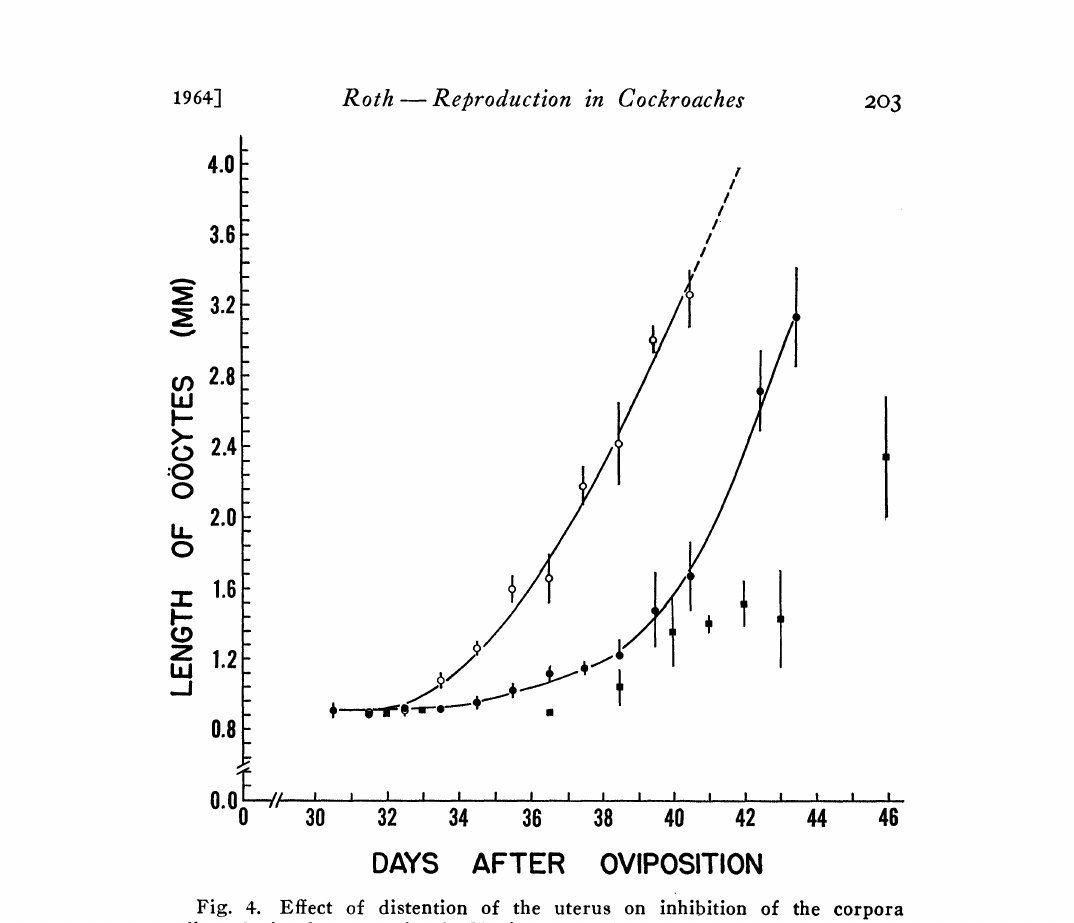
Fig. 4. Effect of distention of the uterus on inhibition of the corpora ,.llta during late gestation in N. cinerea. Solid circles Carrying o/thecae (controls). Ten to 18 females (N 143) used for each point. Open circles O6thecae removed 30-31 days after oviposition; no tube inserted in uteri. Ten females (N 100) used for each point. The average time required to oviposit again, when the o6thecae were removed at 31- 32 days of pregnancy, was 12 days (fig. 2) or 43-44 days after the initial ovi- posit:on. Solid squares O6thecae removed from females 30-31 days after oviposition and glass tubes (4.1-4.3 ram. 10-11 mm.) inserted in the uteri. Five to 16 females (N 92) used for each point. Vertical bars are one standard error but only one-half the error is indicated where they overlapped" no bars indicate standard errors of + 0.02 ram. or less. cease earlier in so.me females with glass inserts than in females carry- ing o6thecae (fig.